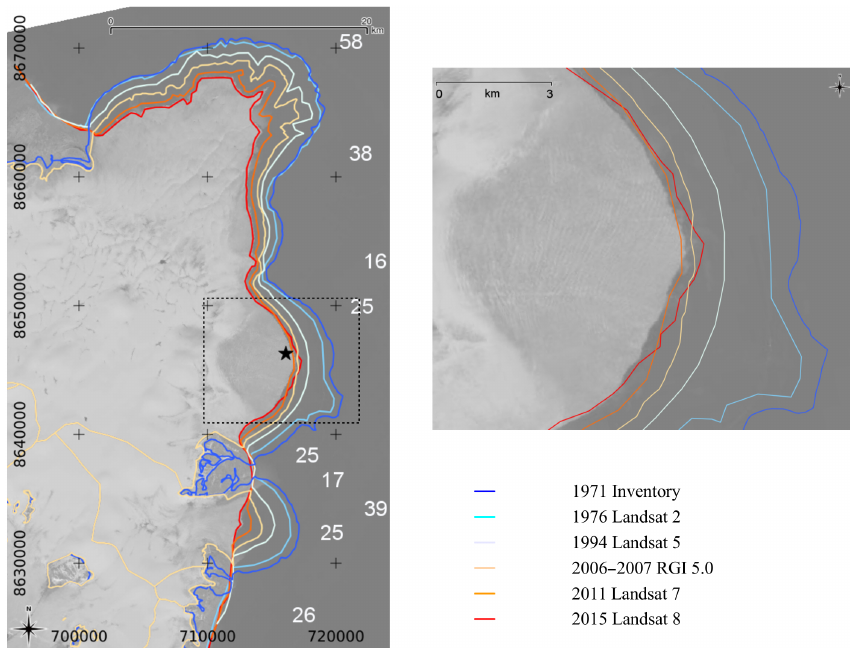
Figure 2. Coastal outlines from vertical aerial photographs in 1971 (Nuth et al., 2013), Landsat imagery from 1976–2015 (this study), and the Randolph Glacier Inventory Version 5.0 (Arendt et al., 2015) in 2006–2007 on a Landsat image of 14 July 2014. Easting and northing coordinates in metres are in the WGS 19:84UTM zone 33 ◦ N. The star indicates the position of the profile on Stonebreen of Fig. 9. The light grey numbers indicate water depths from the Norwegian See Navigation Chart (2016). The inset shows a close-up of the front of the southern lobe